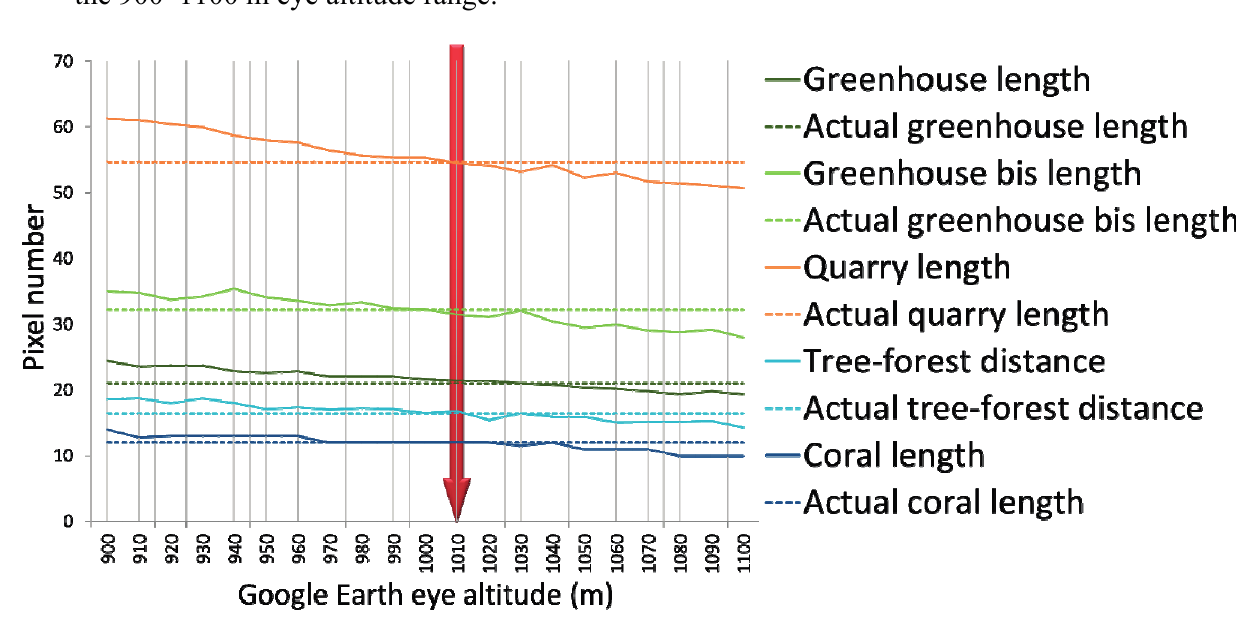
Figure 3. Curve plot linking the Google Earth eye altitude and pixel number characterizing certain coastal targets of reference. The dotted lines correspond to the actual pixel number of each target of reference, measured on the QuickBird image, and the solid lines correspond to the targets’ pixel number derived from the Google Earth images saved along the 900–1100 m eye altitude